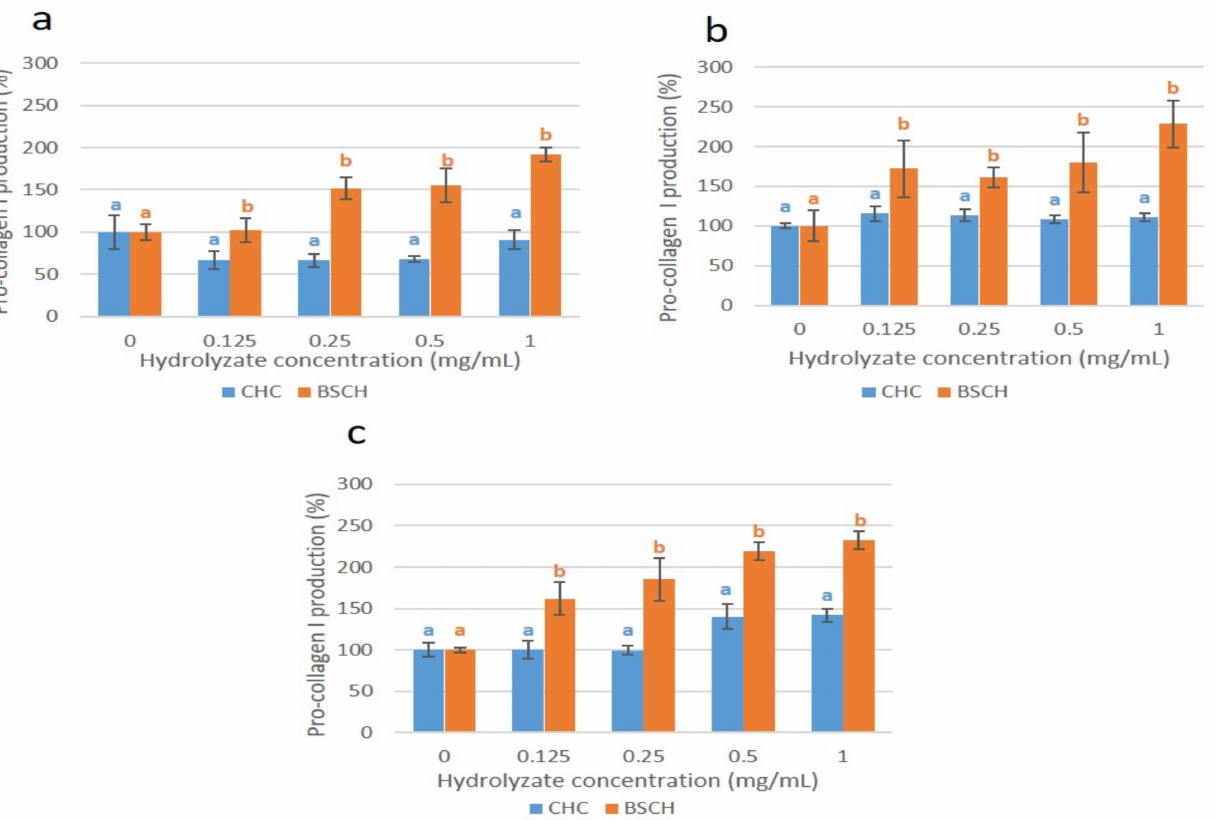
Figure 7. Effect of BSCH-C (orange) and CHC (blue) hydrolysates on collagen production enhance- ment of fibroblast cell cultures at 24 ( a ), 48 ( b ) and 72 ( c ) h. Values are shown as means with standard deviation. Different letters indicate a significant difference between concentration groups ( p <